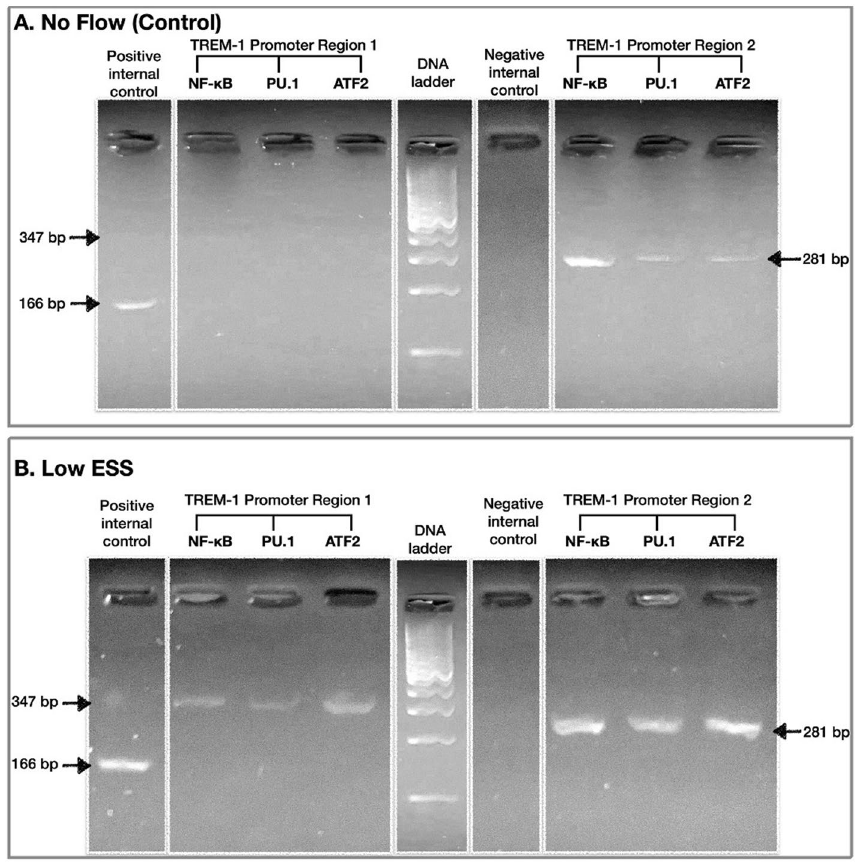
Figure 8. Comparison of the binding of transcription factors (NF-κB, PU.1 and ATF2) to the TREM-1 promoter regions 1 and 2 between low ESS and no flow conditions. 3D co-cultures of HCAECs, HCASMCs, and monocytes (THP-1) were prepared on the coverslips and cultured overnight. Cells were then exposed to low ESS or no flow for or 30 min. ChIP assay was then performed as described in the “Methods”. ESS: endothelial shear stress, TREM-1: triggering receptor expressed on myeloid cells-1, NF-κΒ: Nuclear factor kappa B, ATF2: Activating transcription factor